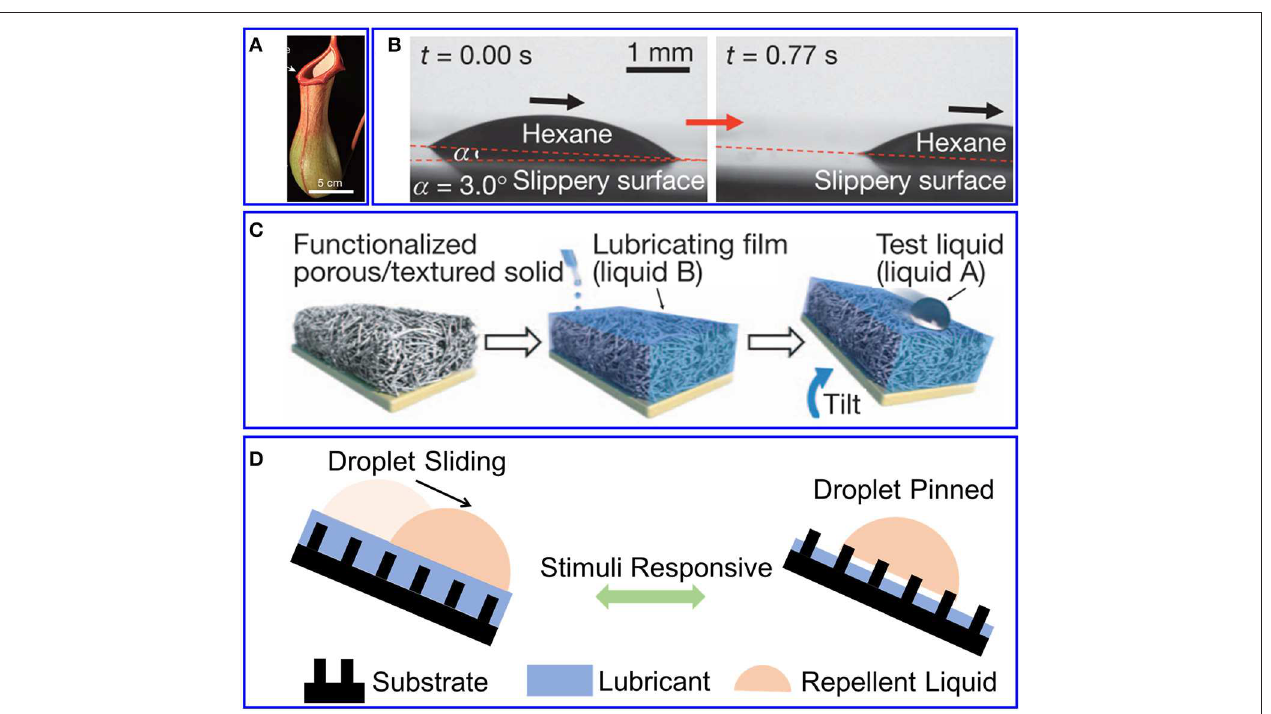
FIGURE 1 | SLIS inspired by pitch plant. (A) Photo of pitch plant (Chen et al., 2016). Reproduced with permission. Copyright 2016, Springer Nature. (B) A droplet of hexane sliding on SLIS ( Wong et al., 2011). Reproduced with permission. Copyright 2011, Springer Nature. (C) Schematic fabrication of SLIS (Wong et al., 2011). Reproduced with permission. Copyright 2011, Springer Nature. (D) Schematic illustration of stimuli responsive